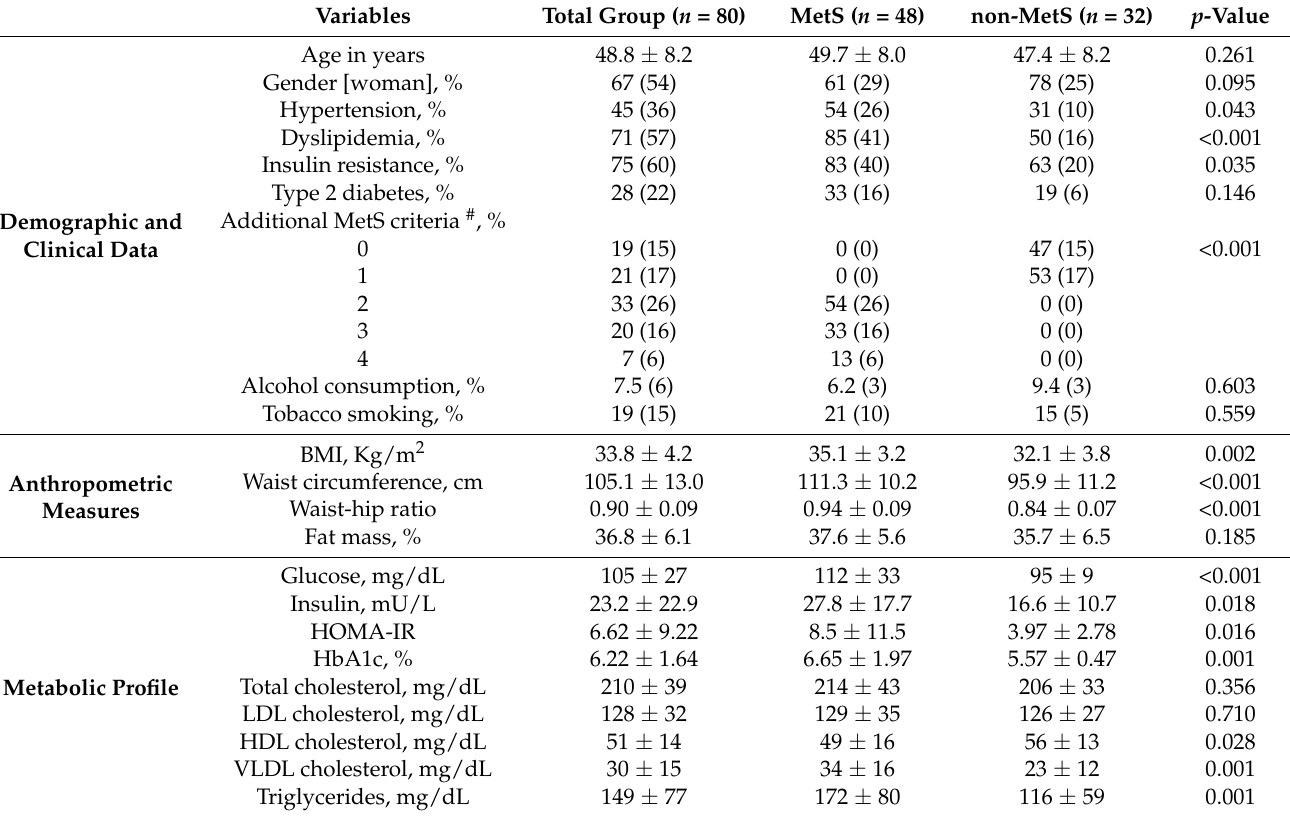
Table 1. Main characteristic of the obese patients according to the MetS